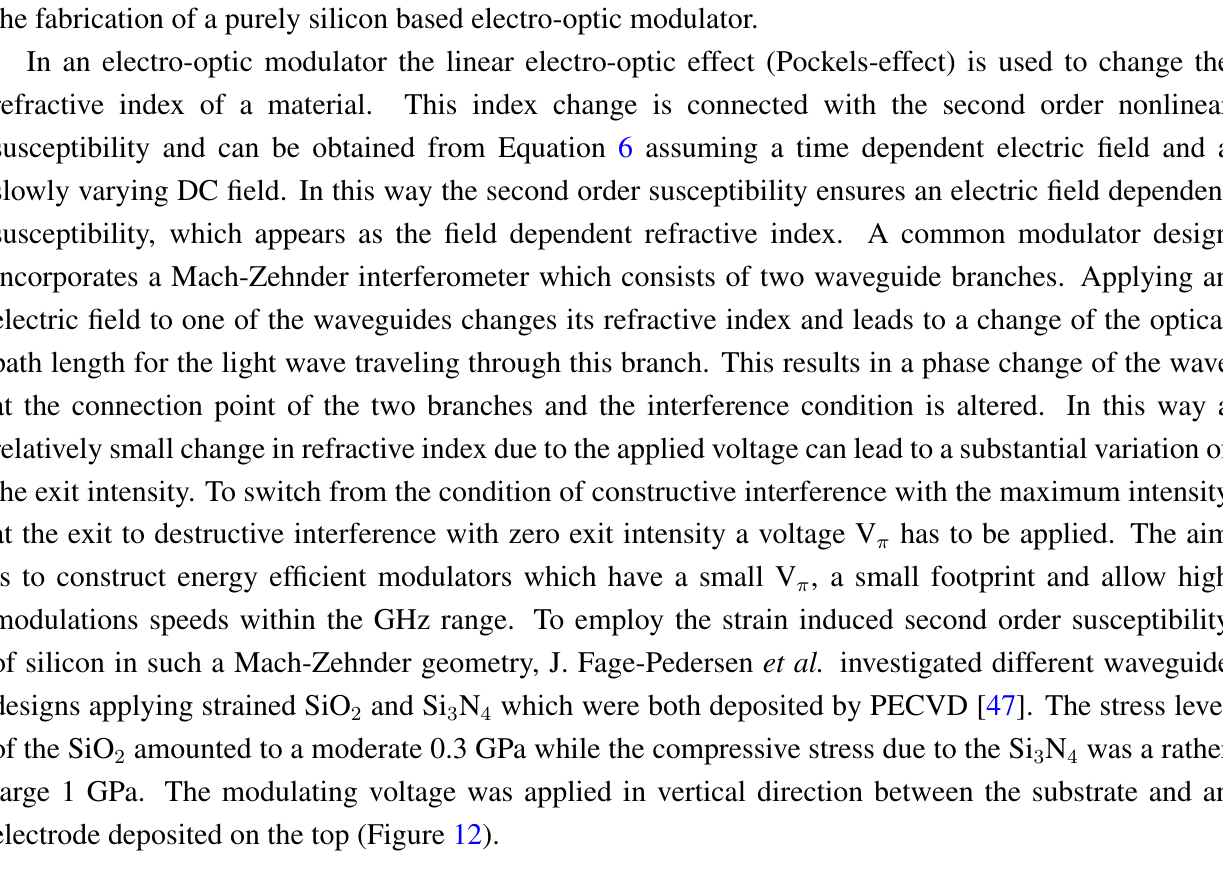
(open squares) and b (filled squares) of the pp ss